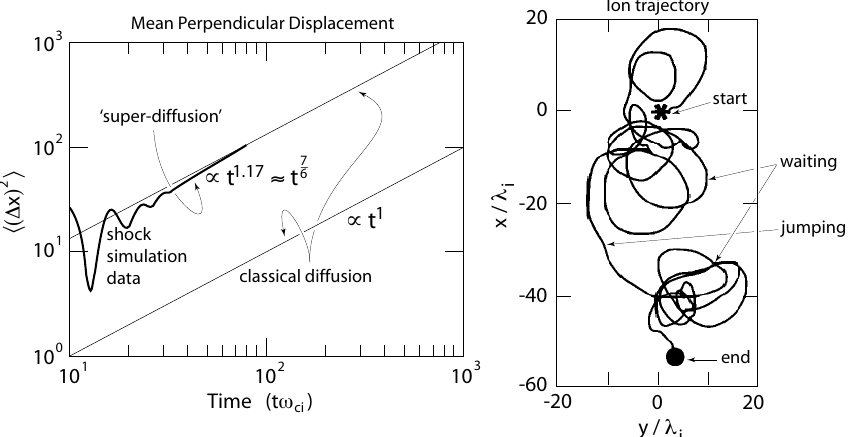
Figure 1. Two-dimensional numerical simulation results of the mean downstream perpendicular displacement of ions near a quasi- perpendicular supercritical shock (shock normal angle θ = 87 ◦ ), Alfvénic Mach number M A = 4 as a function of simulation time (simulation data taken from Scholer et al., 2000, courtesy American Geophysical Union). Distances are measured in ion inertial lengths λ i = c/ω i with ω i ion plasma frequency. (Left) The particle displacement performs an initial damped oscillation before settling into a continuous diffusive increase at time about ω ci t ∼ 40 (in units of the ion gyro frequency ω ci ). The further time evolution deviates apparently only slightly from the classical (linear) increase of the mean displacement, following a h (1x) 2 i ∝ (ω ci t) 1 . 17 power law. (Note that simulation-time limitations did not allow monitoring of the long-time evolution of the ensemble-averaged square displacement, thus inhibiting the determination of the final state of the diffusion process.) (Right) Late time trajectory of an arbitrary ion of the sample used. The orbit is projected into the plane perpendicular to the mean magnetic field which consists of a superposition of the ambient and wave magnetic fields. The ion orbit is neither an undisturbed gyro-oscillation nor a smooth stochastic trajectory. It consists of waiting (trapped gyrating) parts and parts when the ion suddenly jumps ahead a long distance cause by some brief but intense interaction between the particle and wave spectrum. This break out of gyration is typical of rare extreme events like those in Lévy flights referred to in the present